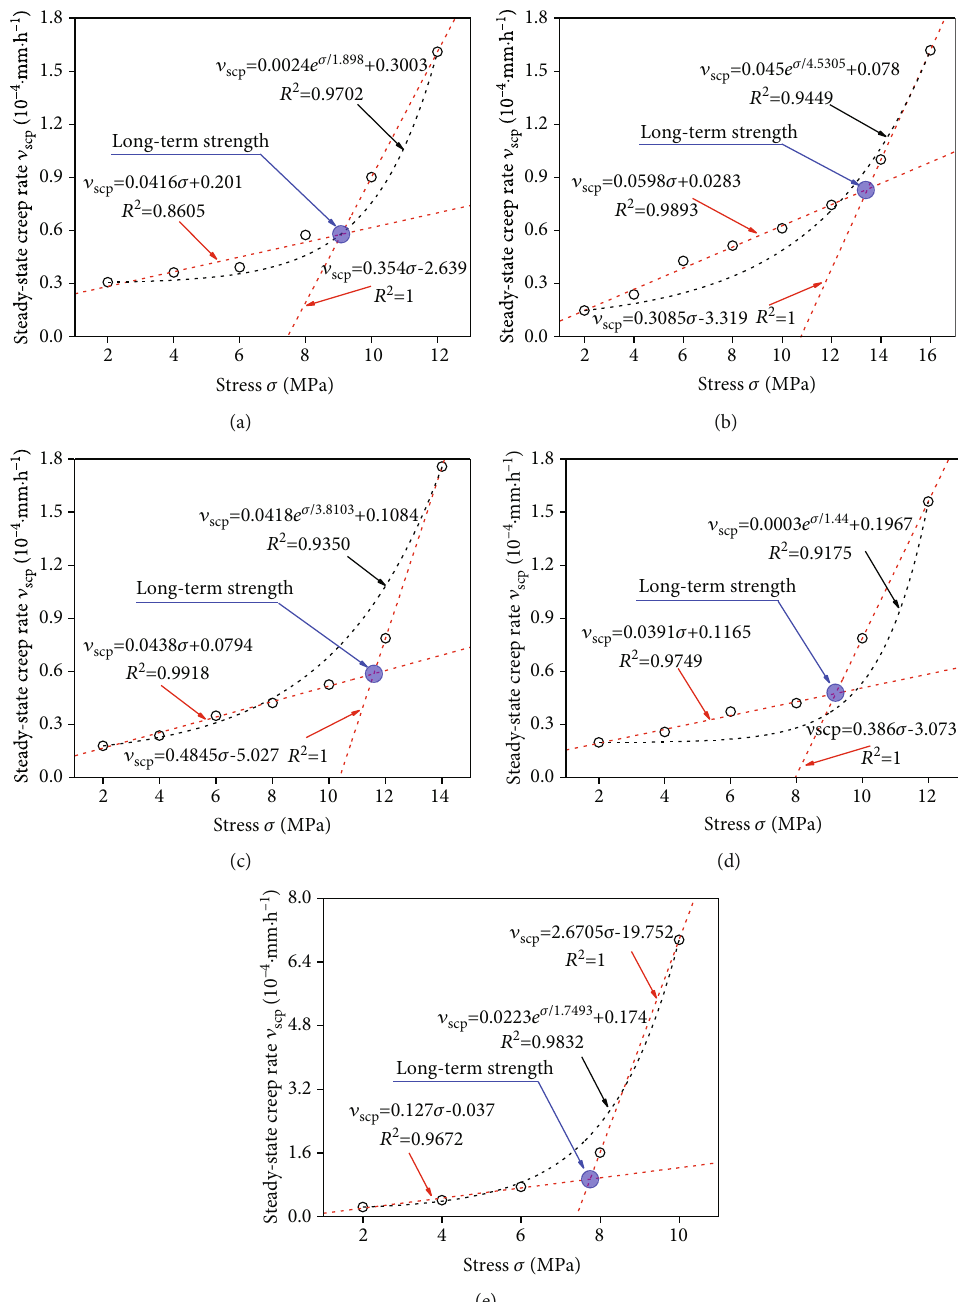
Figure 11: Relationship between steady creep rate and stress level of coal specimens under di ff erent moisture contents: (a) ω = 0 % , (b) ω = 2 : 42 % , (c) ω = 5 : 53 % , (d) ω = 7 : 55 % , and (e) ω = 10 : 08 %